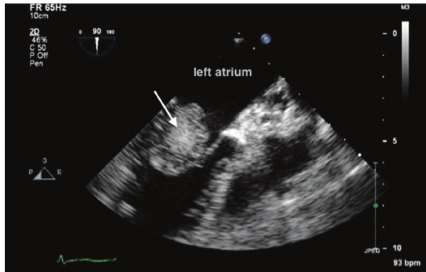
Figure 1: Echocardiogram showing left atrial myxoma (arrow).